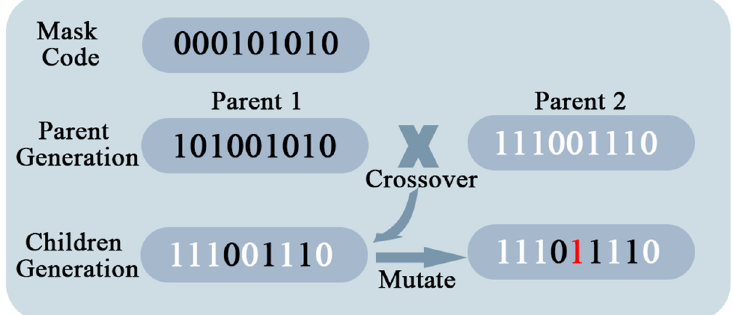
Figure 5. Crossover and